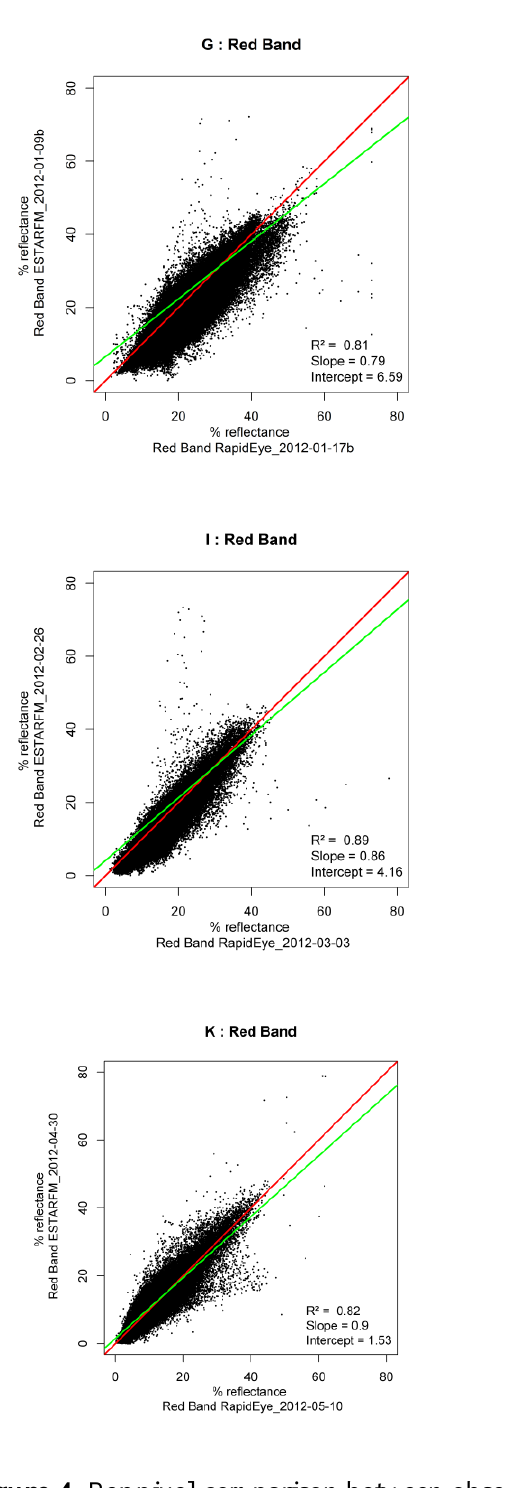
Figure 4. Per-pixel comparison between observed and predicted RapidEye reflectance for the assessment pairs as listed in Figure 2. The 1:1 line is shown in red, the regression line in green. Plots ( left column ) illustrate the reflectance values for the red band, plots ( right column ) the values for the NIR band. The x-axis displays the values of the respective RapidEye image, the y-axis the values of the correspondent predicted ESTARFM